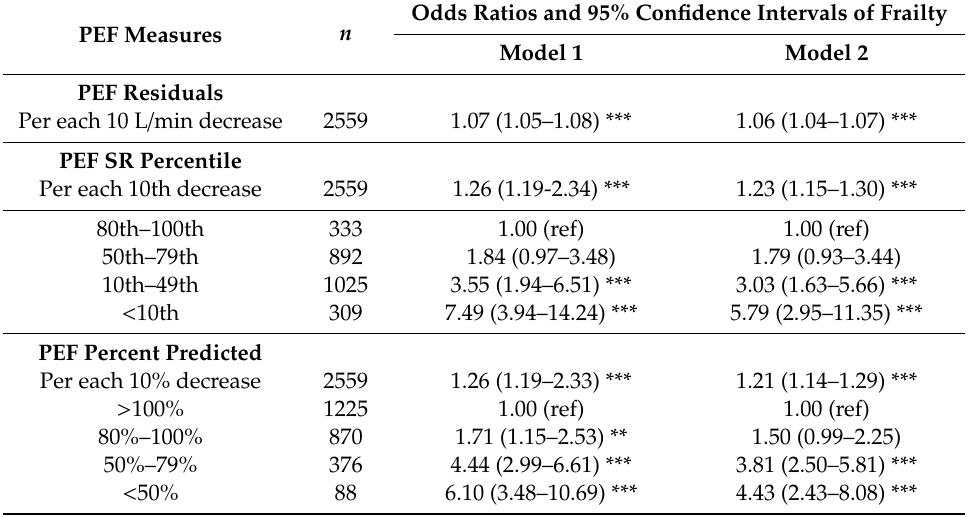
Table 2. Cross-sectional association between peak expiratory flow and